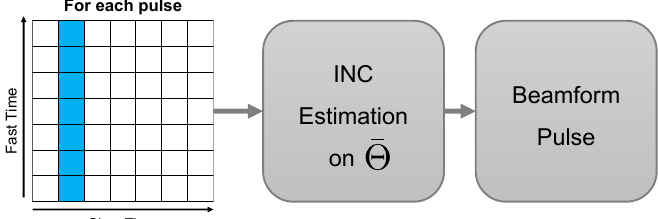
Figure 5. Pulse-Wise Minimum Variance Distortionless Response (MVDR) RFI mitigation with DBF. A mitigation of N − 1 interferers per pulse is possible.